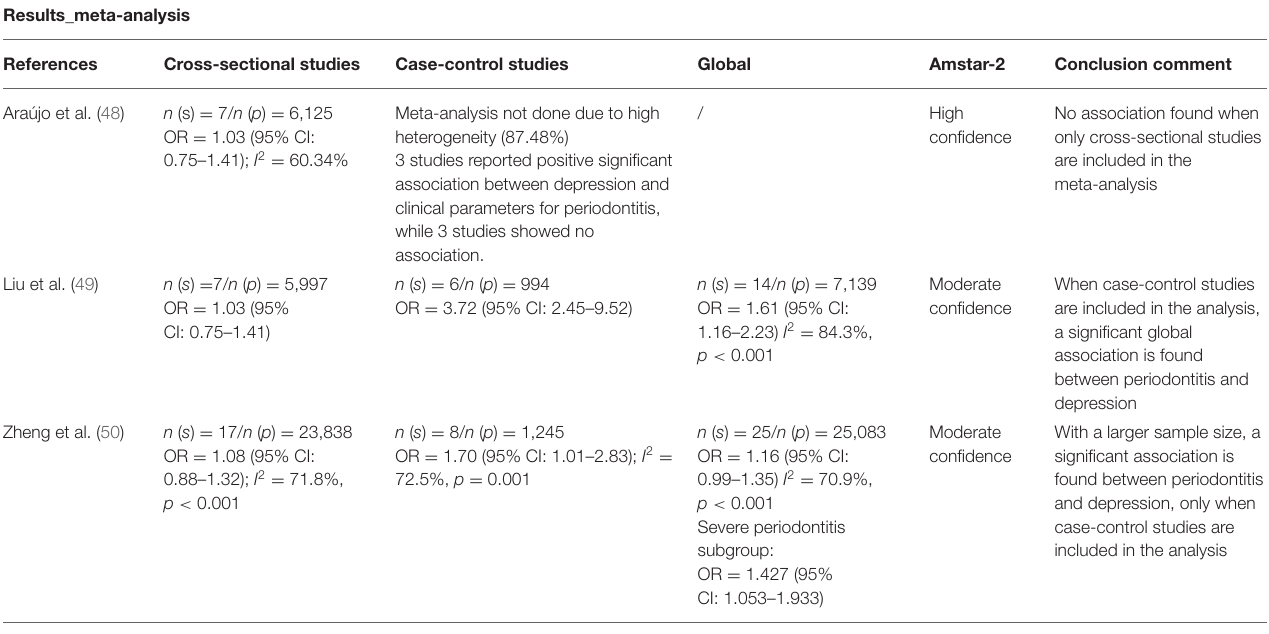
TABLE 1C | Main characteristics of systematic reviews dealing with the association between periodontitis and depression: results and conclusion remarks.